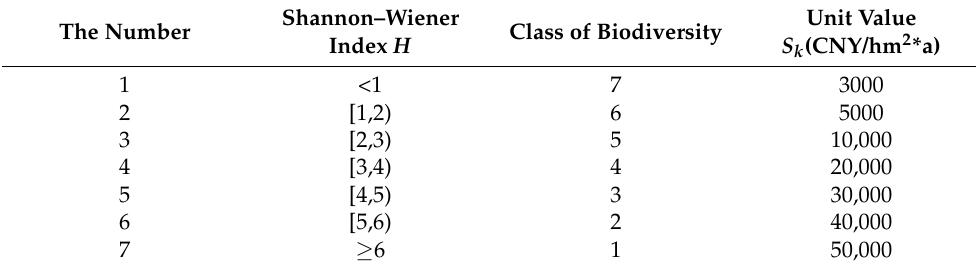
Table 4. Value division of the grades of Shannon–Wiener Index H